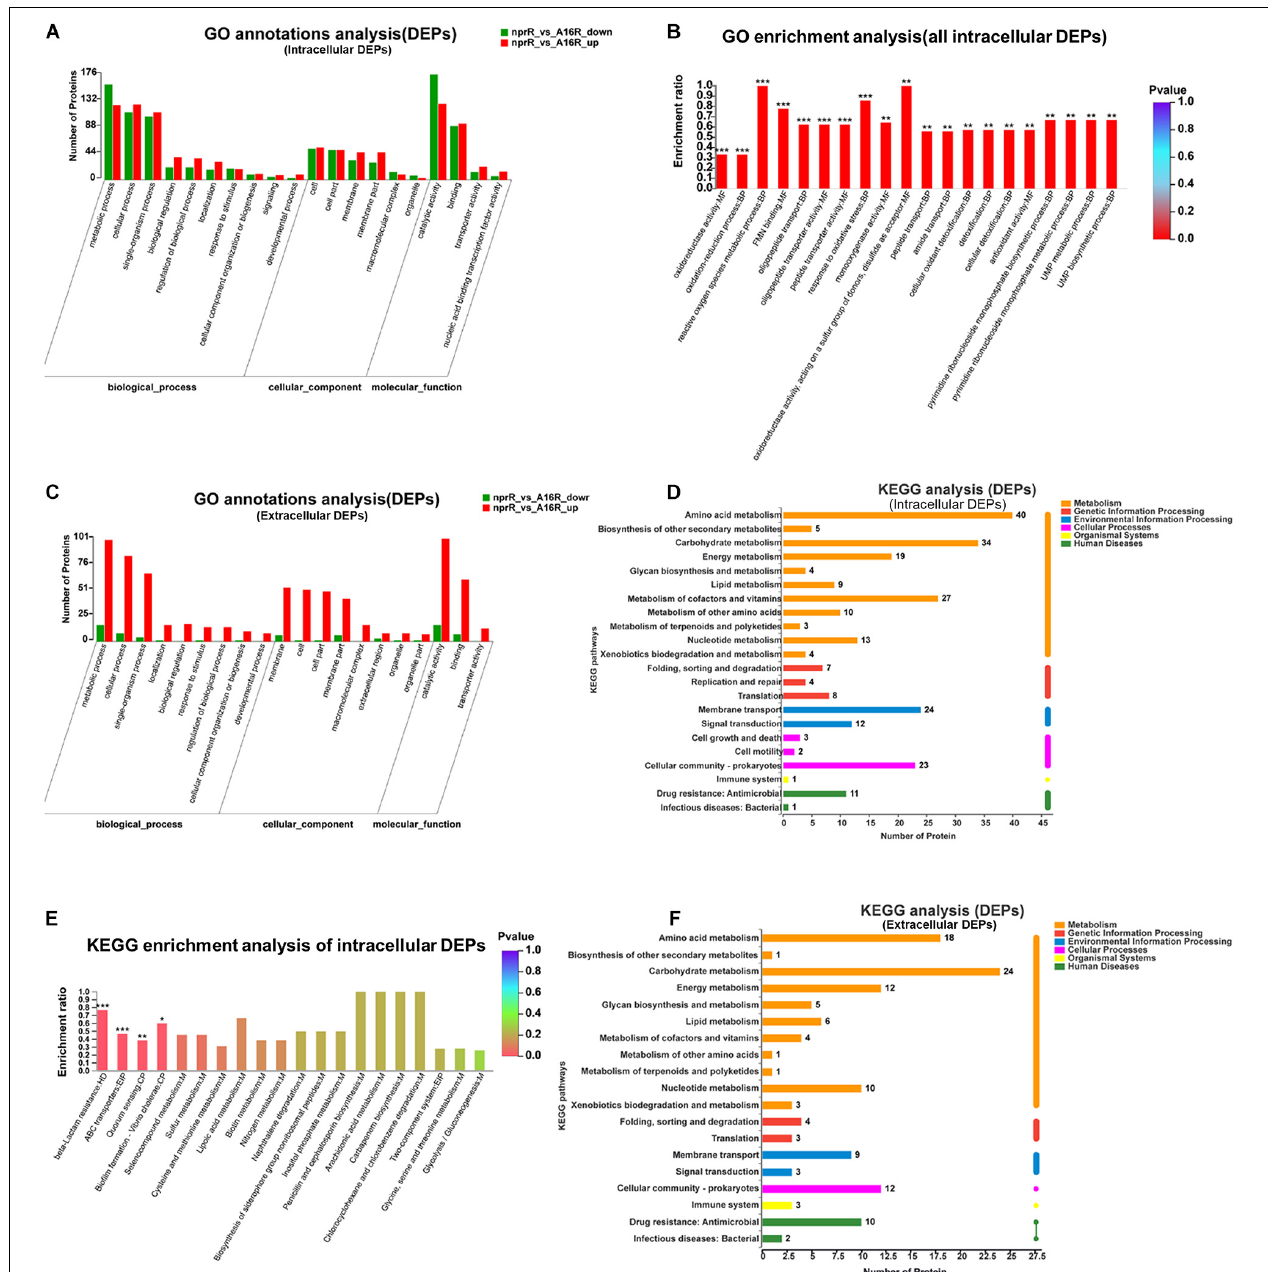
FIGURE 4 | Functional classification of DEPs. (A) GO annotation of intracellular DEPs. (B) GO functional enrichment analysis of intracellular DEPs. (C) GO annotation of extracellular DEPs. (D) KEGG annotation of intracellular DEPs. (E) KEGG pathway enrichment analysis of intracellular DEPs. (F) KEGG pathway annotations of extracellular DEPs. * P < 0.05, ** P < 0.01, *** P <